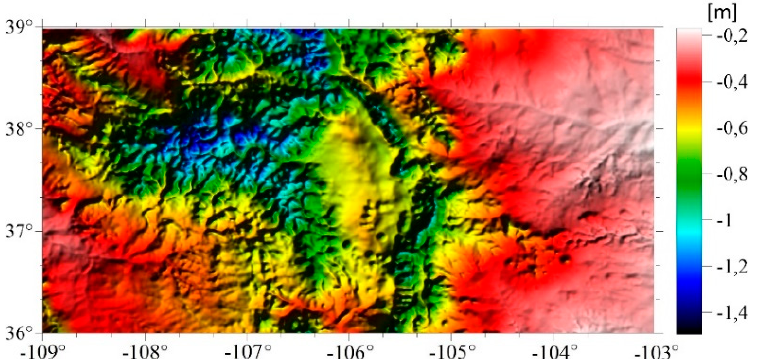
Figure 6. Map of CBA values used for gravity prediction.